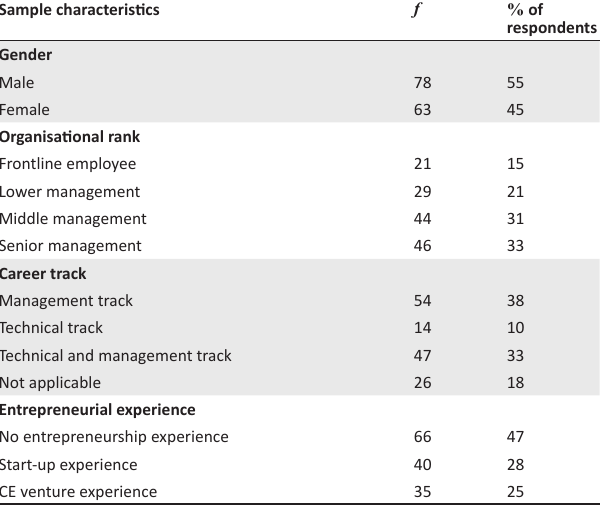
TABLE 1a: Characteristics of respondents.